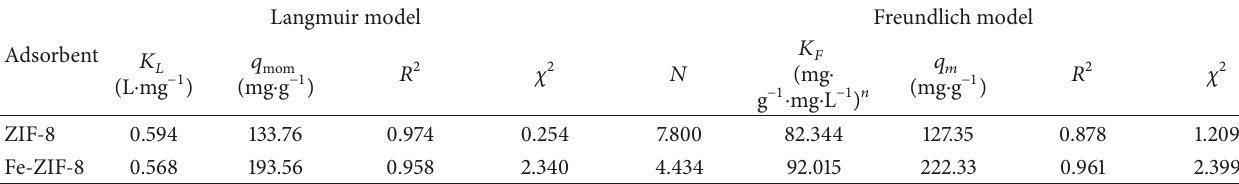
Table 9: The parameters of Langmuir and Freundlich